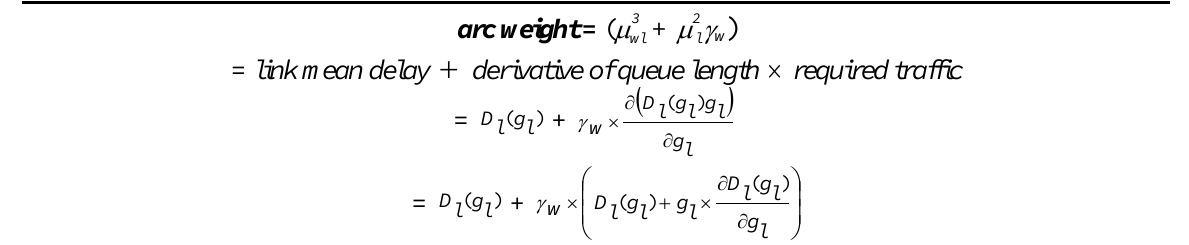
Table 4. Arc weight of each